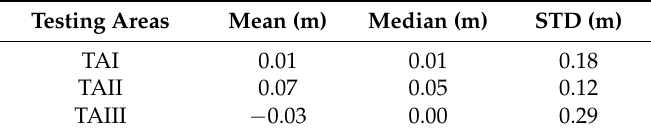
Table 2. Statistics of the DoD maps (vertical changes) for TAI, TAII, and TAIII shown in Figure 6 demonstrate the loss and gain of mass within the selected